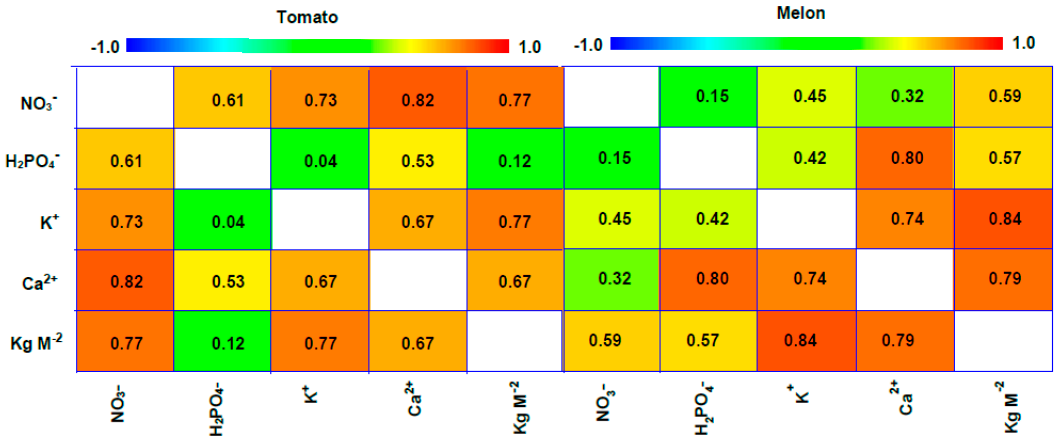
Figure 4. Pearson correlation analysis between yield and petiole cellular extract (PCE) concentrations.